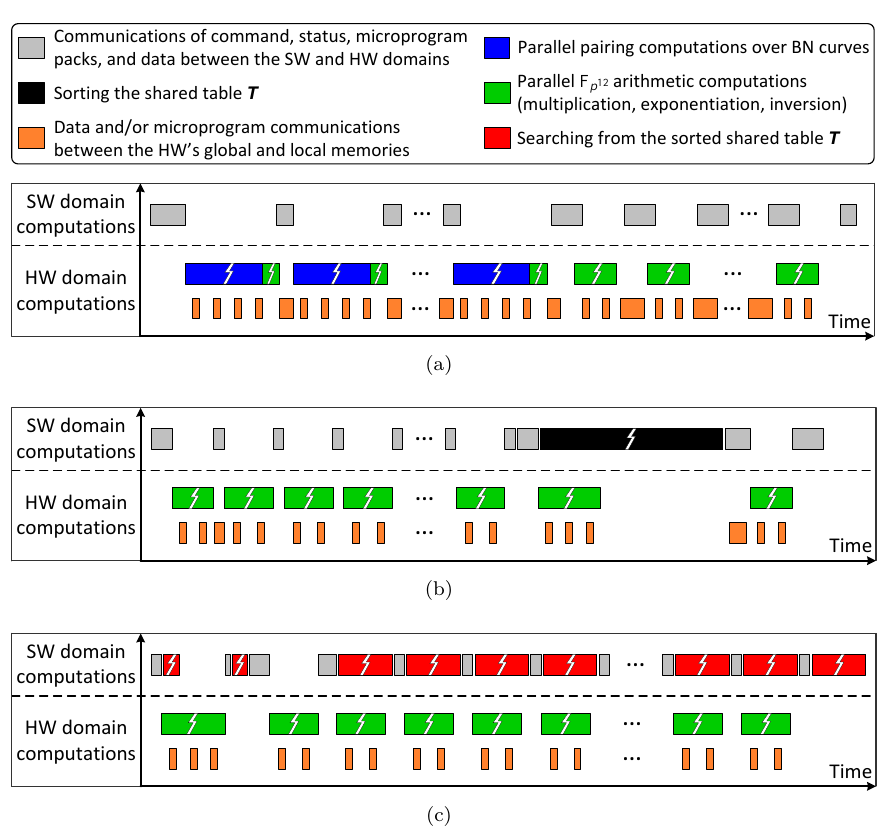
Figure 4: Implementation and timing diagrams of (a) the parallel pairings and F arithmetic computations of Alg. 1 (i.e., lines 1-6), (b) the precomputation part of Alg. 4(a), and (c) the on-the-fly computation part of Alg.